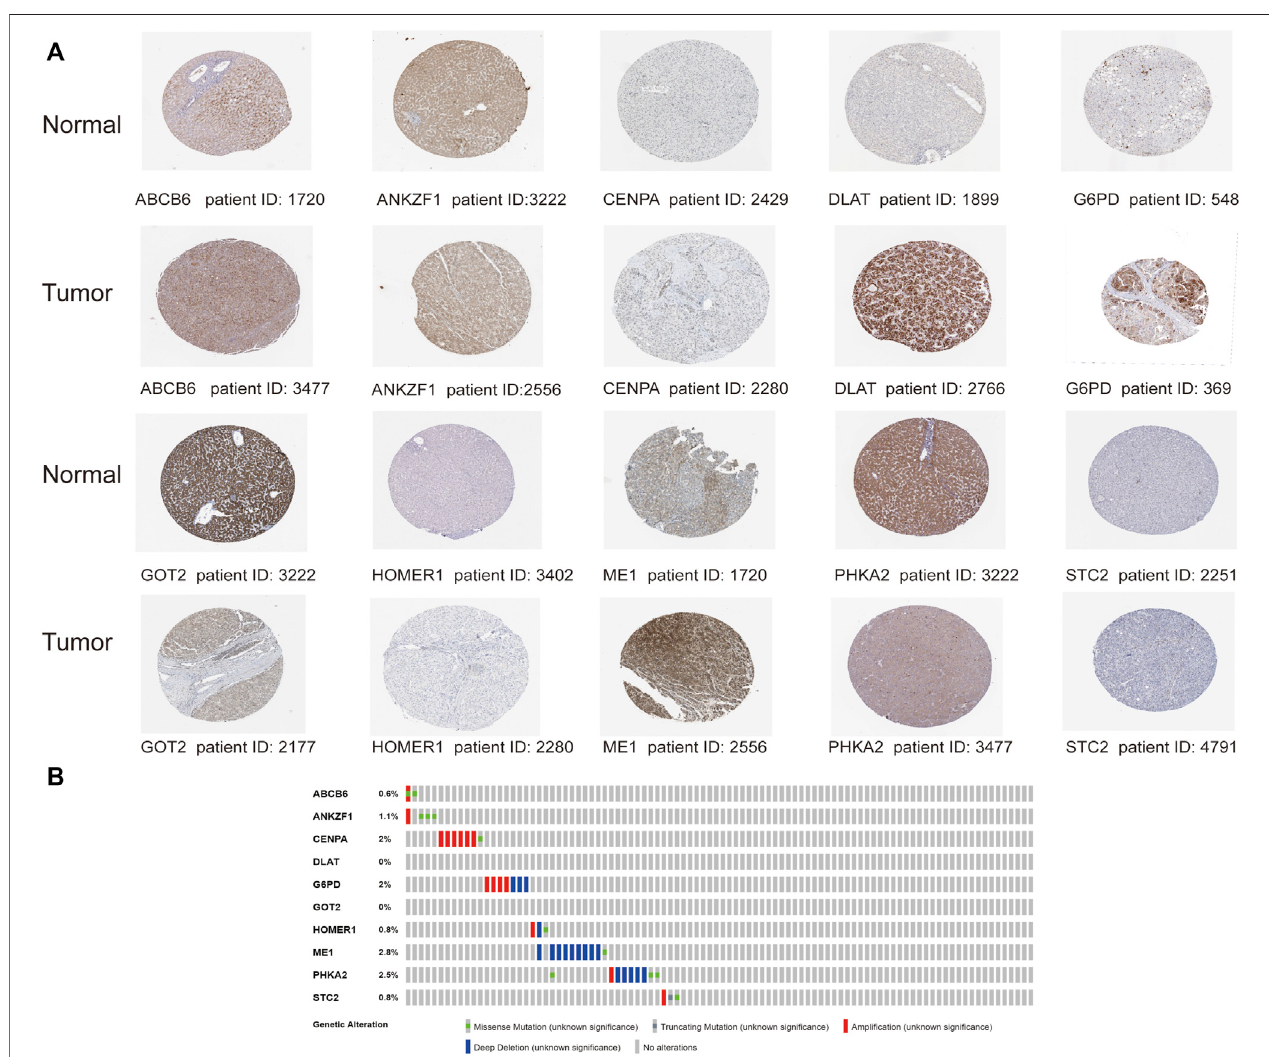
FIGURE11| Analysisoftheprotein expressionandgenemutationofthegenesintherisksignature. (A) ImmunohistochemistrystainingdatainHCCtumor tissues and normal tissues from The Human Protein Atlas. (B) Mutations of the 10 genes in HCC patients.